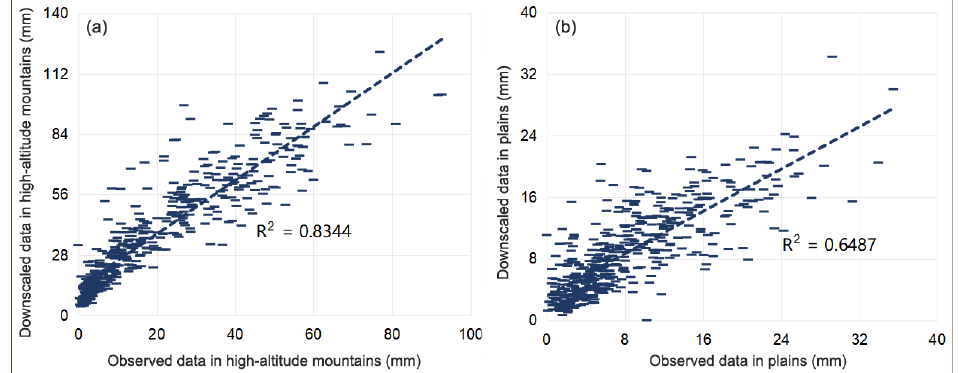
Figure 2. Accuracy of the downscaled dataset in high-altitude mountains ( a ) and plains ( b ). To assess the improvement of downscaling, we compared the accuracy before and after downscaling. Table 4 indicates that the accuracy of the downscaled dataset is better than the ERA5 reanalysis in both high-altitude mountains and plains. In high-altitude mountains, the slope of downscaled data and observations is 1.24, the NSE is 0.83, and MAE and RMSE are both lower than 9 mm, while the Slope of ERA5 reanalysis and ob- servations is 1.47, the NSE is 0.61, and MAE and RMSE are both higher than 9 mm. In plains, the slope of downscaled data and observations is 1.16, the NSE is 0.65, and MAE and RMSE are both lower than 9 mm, while the slope of ERA5 reanalysis and observations is 1.33, the NSE is 0.49, and MAE and RMSE are both higher than 9.5 mm. The above results indicate that there is a significant improvement in downscaling. Table 4. Accuracy comparison of downscaled dataset and ERA5 reanalysis. Area